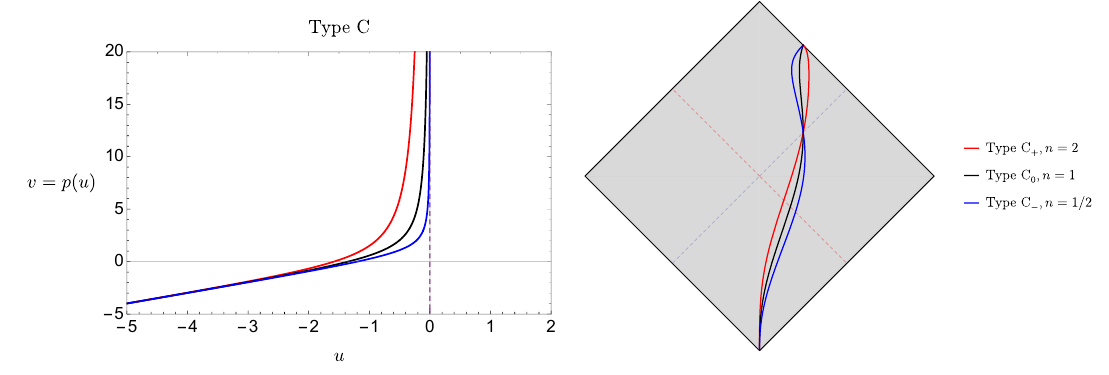
Figure 7 . Type C mirrors with u end = 0 . Left: three different types of conformal mapping functions ( u ) as defined in eq. (4.5) with n = 2 , 1 , 1 p C type C , C , C mirrors. The three subclasses are given in table + 0 −